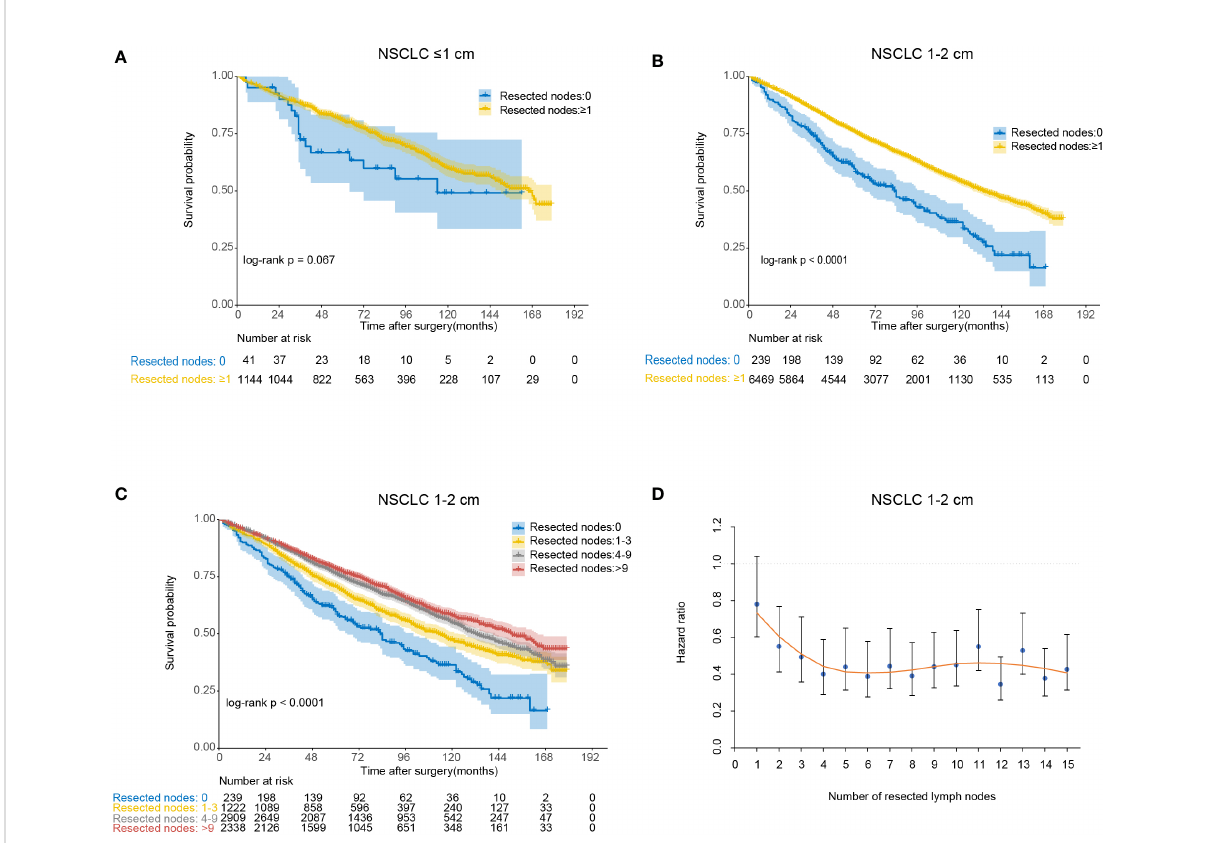
FIGURE 3 The association between the number of resected lymph nodes and overall survival for lobectomy. (A) Kaplan-Meier analysis of overall survival between no lymph nodes resected group and lymph nodes resected group for non-small cell lung cancer (NSCLC) ≤ 1 cm; (B) Kaplan-Meier analysis of overall survival between no lymph nodes resected group and lymph nodes resected group for NSCLC 1-2 cm; (C) Kaplan-Meier analysis of overall survival among different lymph nodes resected groups (0, 1-3, 4-9 and >9) for NSCLC 1-2 cm; (D) Locally estimated scatterplot smoothing (LOESS) curve describing the association between the speci fi ed number of resected lymph nodes and corresponding hazard ratio (HR) for NSCLC 1-2 cm.